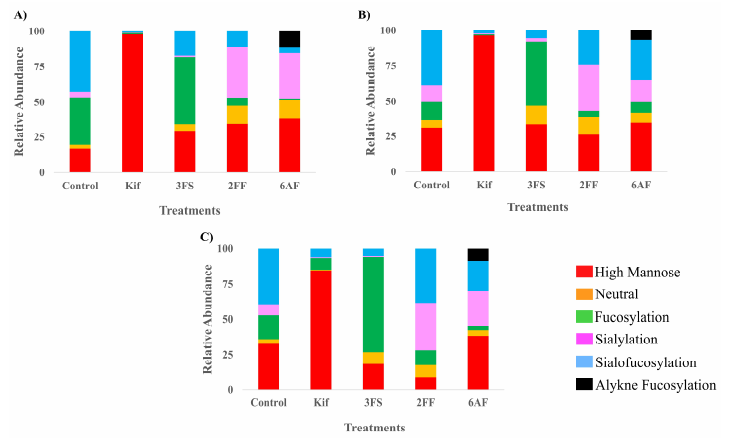
Figure 4. The relative abundance profile of each glycosylation inhibitor with its control counterpart plotted on stack columns with ( A ) Caco-2, ( B ) A549, and ( C ) PNT2 cell lines. Stack column plots are color coded by glycan subtypes.